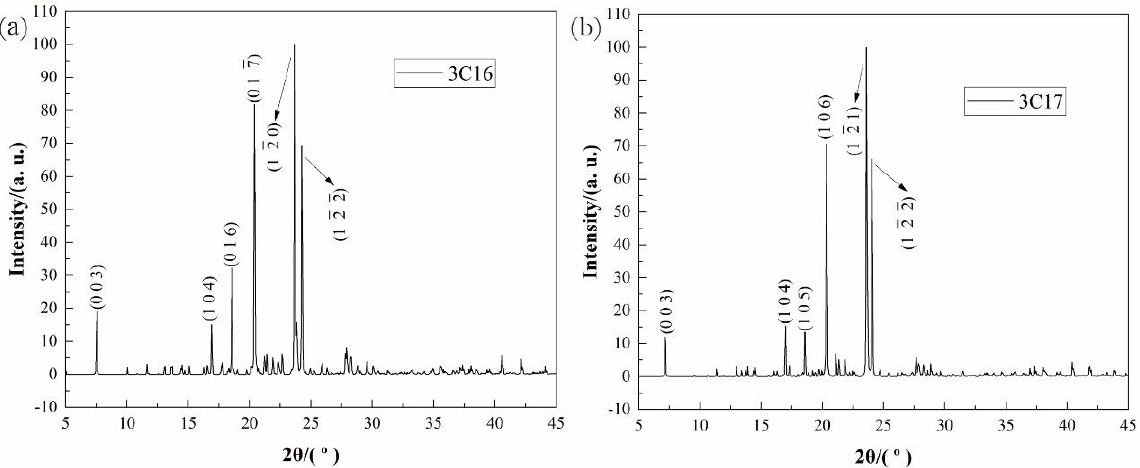
Figure 16. X-ray diffraction patterns of samples the two molecules: where ( a ) represents 3C16 and ( b ) represents 3C17.